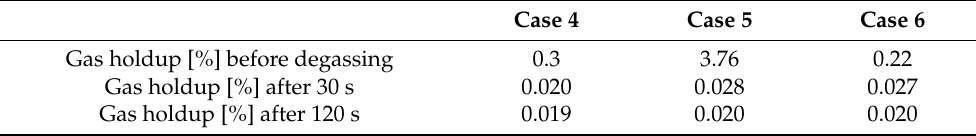
Table 5. Gas holdup while degassing at t = 0 s, t = 30 s, and t = 120 s for different flow